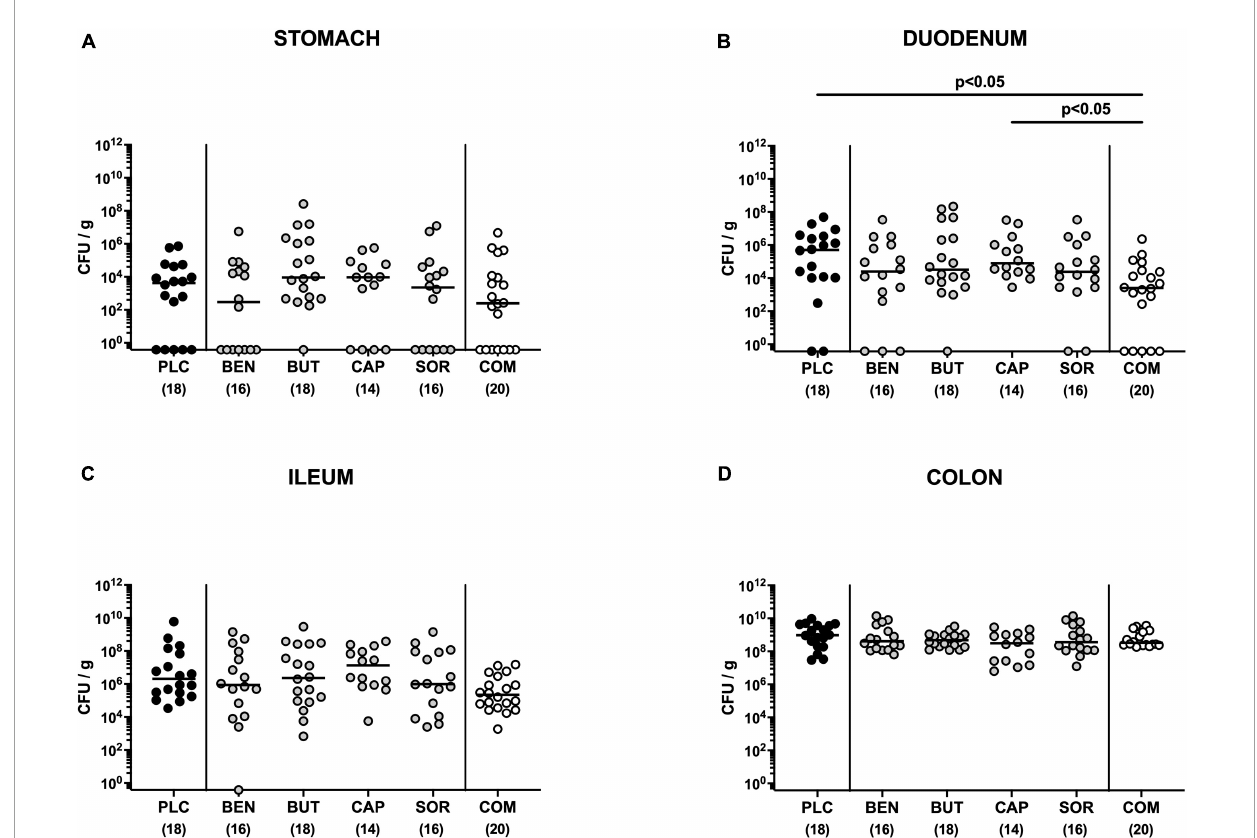
FIGURE2 Gastrointestinal pathogen loads following single and combined organic acid treatment of infected mice. Starting on day 2 post-infection, the mice were treated with benzoic acid (BEN), butyric acid (BUT), caprylic acid (CAP), sorbic acid (SOR), or a combination (COM) of respective organic acids via the drinking water for 4 days. The placebo (PLC) group only received autoclaved tap water. On day 6 post-infection, C. jejuni loads were determined in luminal samples taken from the (A) stomach, (B) duodenum, (C) ileum, and (D) colon by culture (colony forming units per gram; CFU/g). Medians (black bars), significance levels ( p values) calculated by the ANOVA test with Tukey’s post-correction or by the Kruskal–Wallis test and Dunn’s post-correction, and the total mice numbers (in parentheses) are given. Data were pooled from three independent